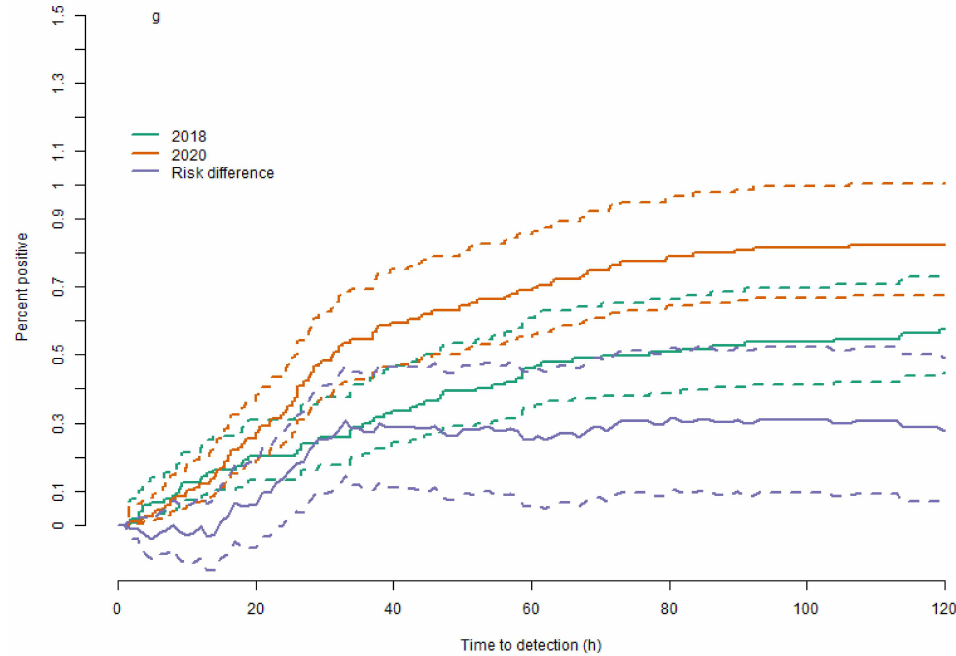
Figure 2. Time to detection of fungi-blood culture sets. The figure shows the cumulative incidence function curves with 95% confidence intervals for blood culture sets drawn in 2018 (before the implementation of dedicated mycosis flasks) and in 2020 (after the implementation of dedicated mycosis flasks) and the absolute difference between the two estimates. Figure ( a ) is the overall estimates for all blood culture sets with yeast, and Figure ( b ) is the overall estimates for all blood culture sets from hospitals that used the BacTAlert™ system in 2018, in 2020, the BACTEC™ system was used at these hospitals, ( c ) shows the estimates for low-risk departments for all blood culture sets from hospitals that used the BacTAlert™ system in 2018 ( d ) shows the estimates for high-risk departments for all blood culture sets from hospitals that used the BacTAlert™ system in 2018, ( e ) shows the overall estimates for all blood culture sets from hospitals that used the BACTEC™ system in 2018, these hospitals also used the BACTEC™ system in 2020, ( f ) shows the estimates for low-risk departments for all blood culture sets from hospitals that used the BACTEC™ system in 2018, ( g ) shows the estimates for high-risk departments for all blood culture sets from hospitals that used the BACTEC™ system in